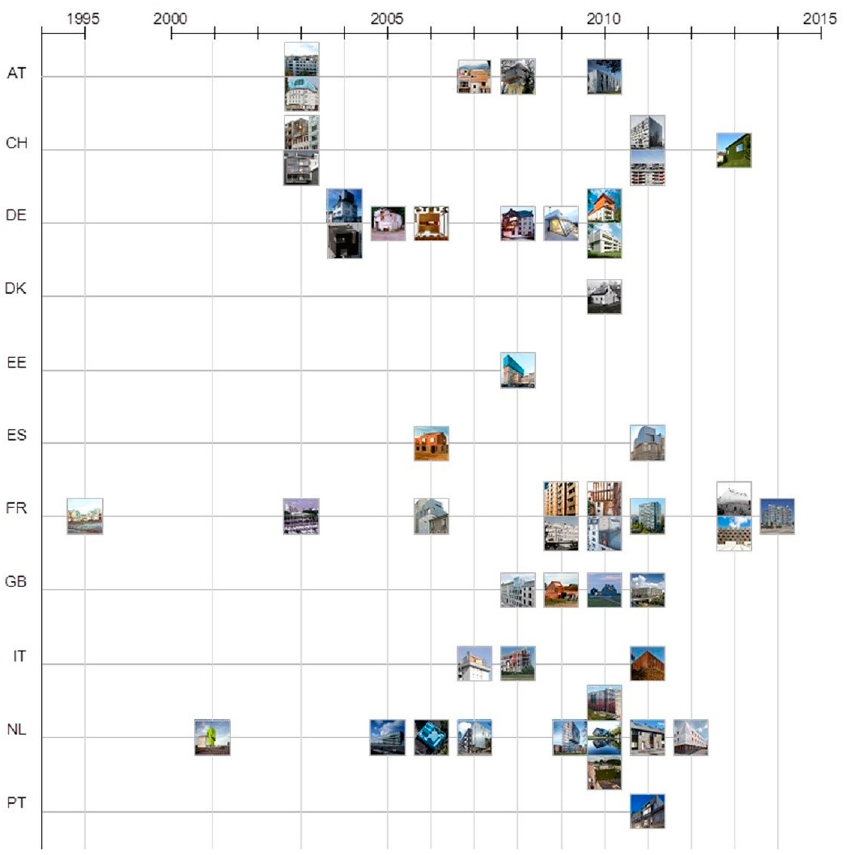
Figure 1. Locations and periods of the selected best practices.